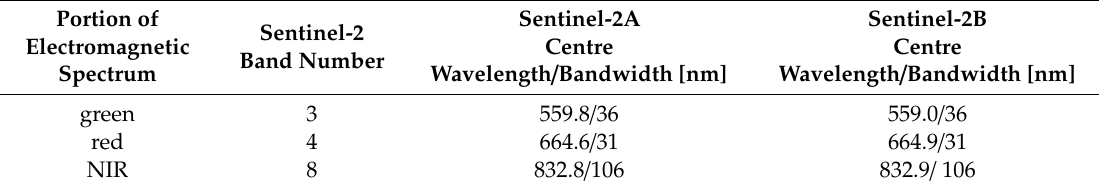
Table 3. Centre wavelength and bandwidths of the applied Sentinel-2 reflectance data and input for spectral indices